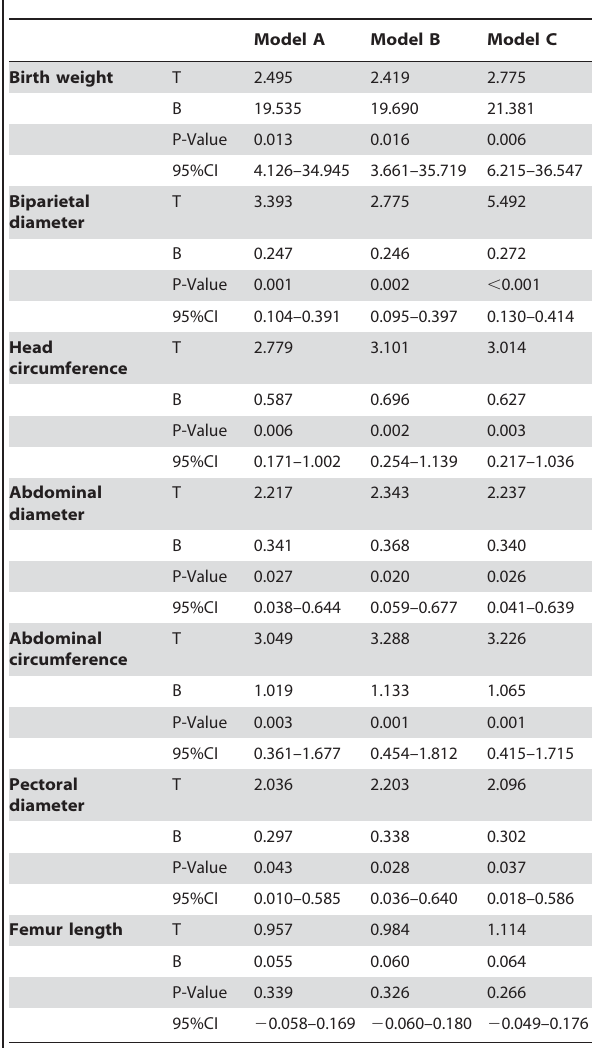
Table 3. Multivariable regression analysis of the association between ultrasound measurements in late gestation or birth weight and paternal BMI in newborn boys.